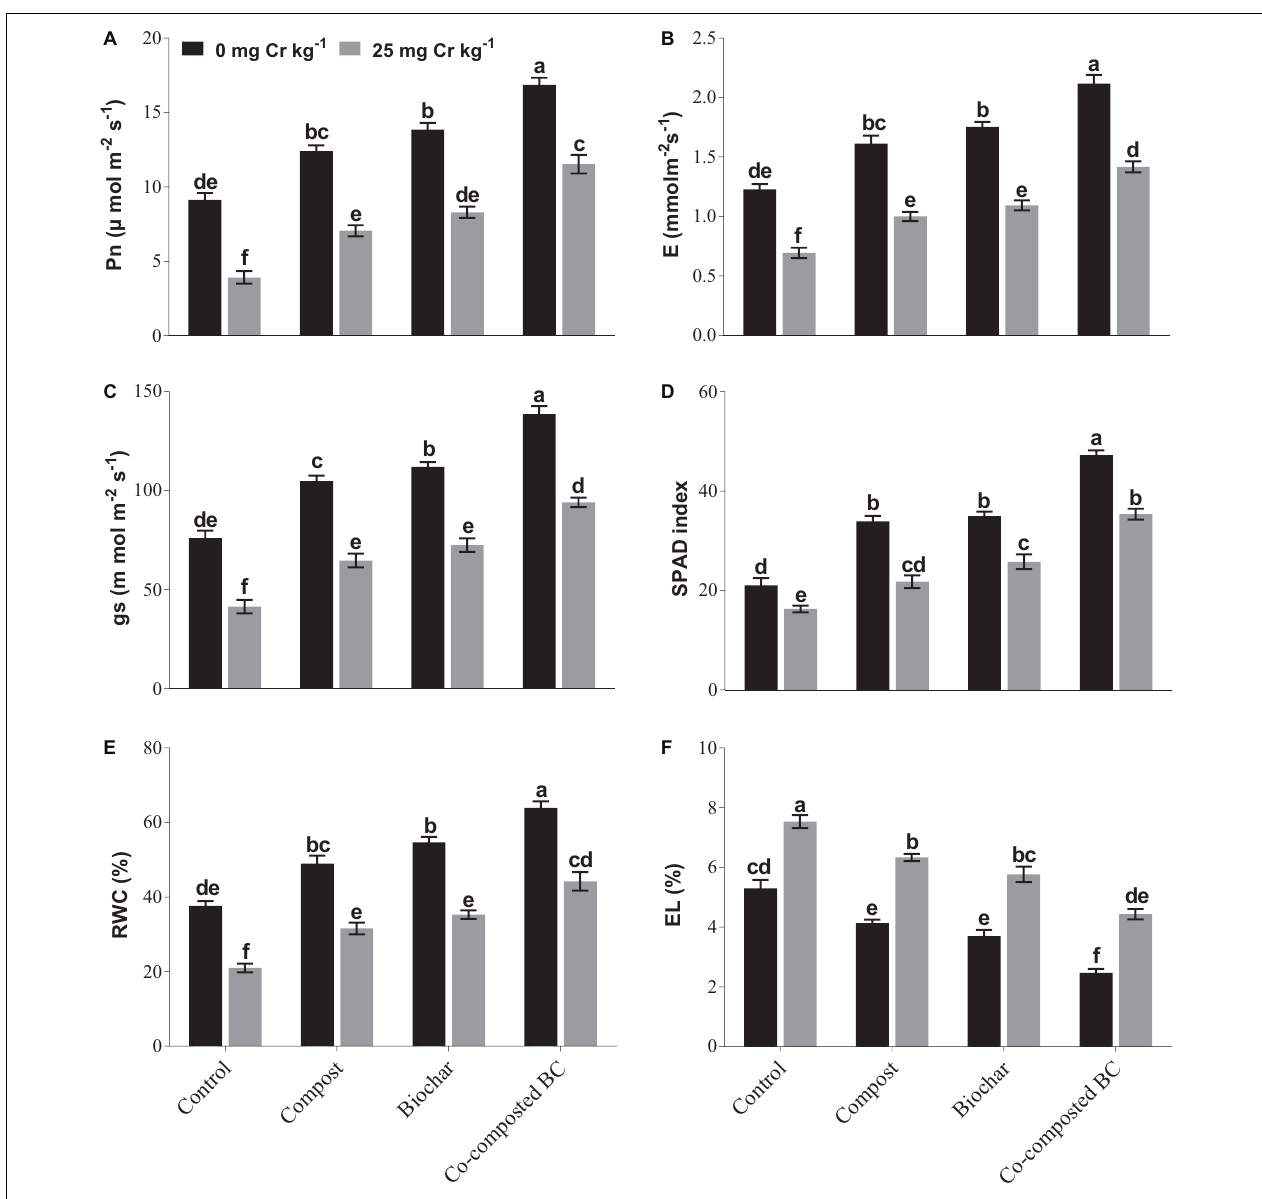
FIGURE 2 | Impact of compost, biochar, and co-composted biochar on physiological parameters of Brassica . (A) Photosynthetic rate, (B) transpiration rate, (C) stomatal conductance, (D) chlorophyll content, (E) relative water content, and (F) electrolyte leakage. The values are presented as mean ± standard error ( n = 3). The values sharing the same letter(s) in bars are statistically non-significant with each other at p <